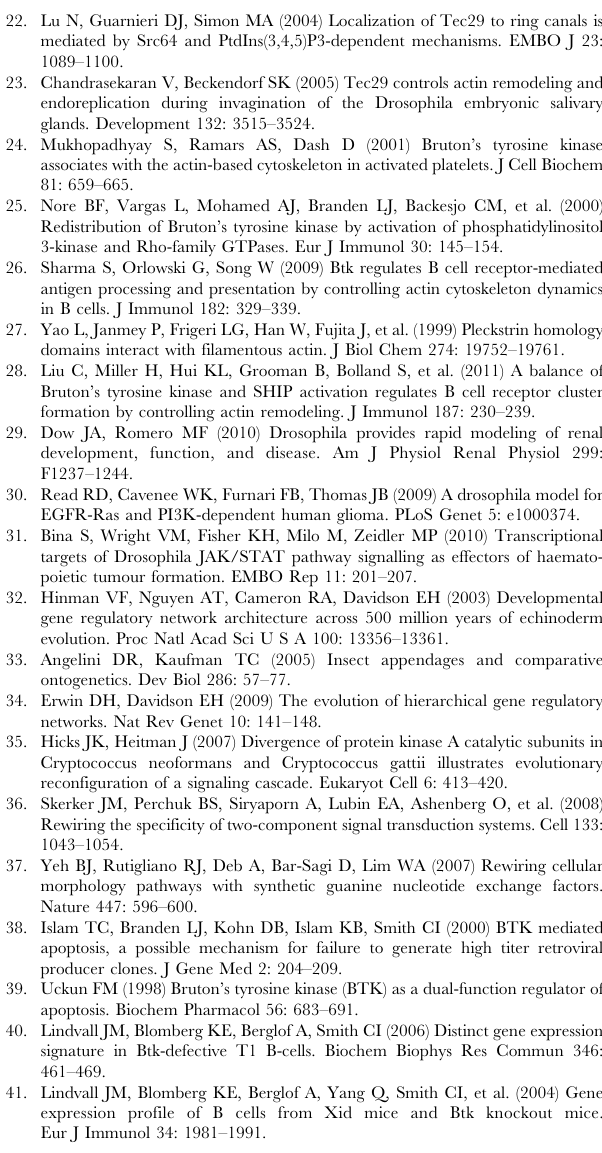
Figure S3 Gene Set Enrichment Analysis for Gene Ontology (biological process) clusters for the 744 Btk- dependent transcripts found in adult head tissue: Enriched clusters of Biological Processes were found in the Btk- dependent Adult head tissue analysis and were statistically significant. For the main Figure 6, Figure S3 shows the respective genes found for each cluster (grey-zoned in Figure 6). The genes belonging to respective cluster are marked in either red (up-regulated) or blue (down-regulated) depending on the direction of the gene.